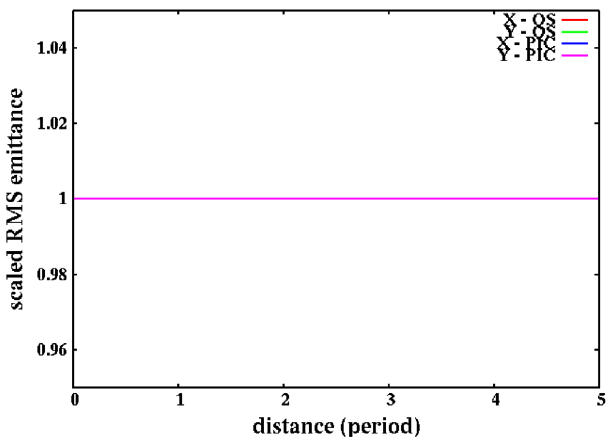
FIG. 3. Horizontal (x) and vertical (y) rms emittance evolution through a five period FODO lattice from the quantum Schrö- dinger method (red and green) and from the PIC method (blue and magenta) without including the space-charge